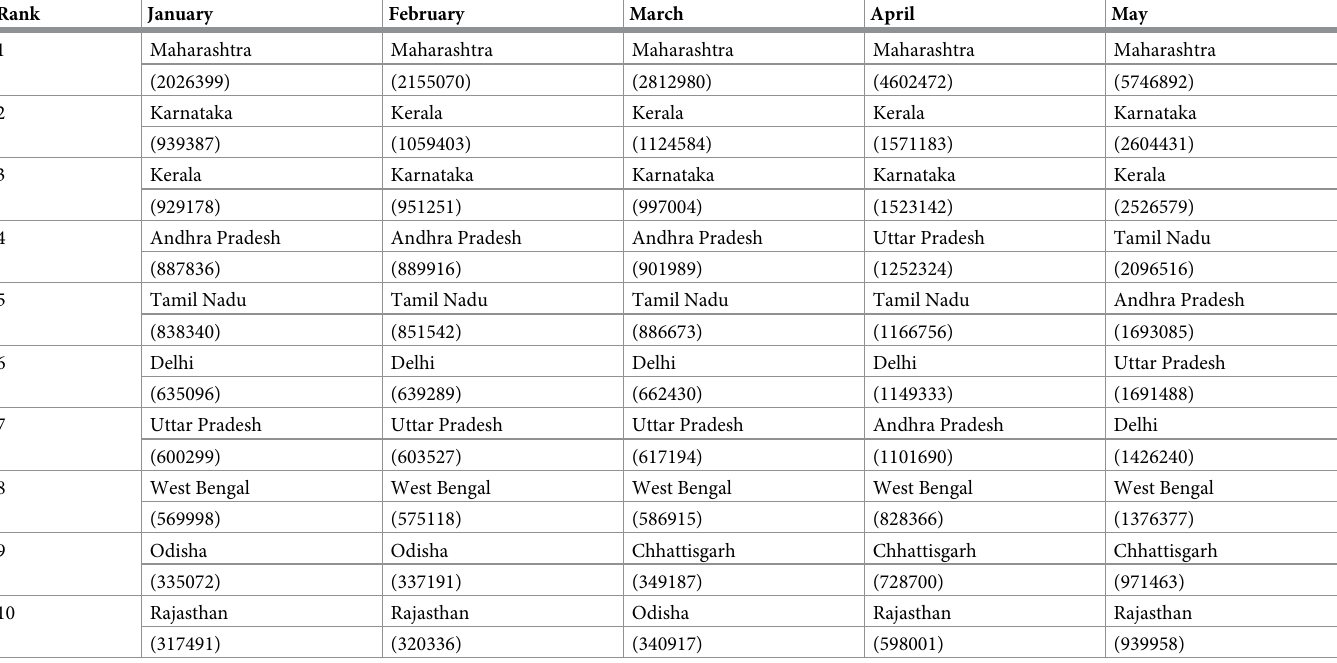
Table 3. Rank of states by number of novel total cases taken at the 1st of every month for January to May 2021 [15]. The number of novel cases are shown in brackets.